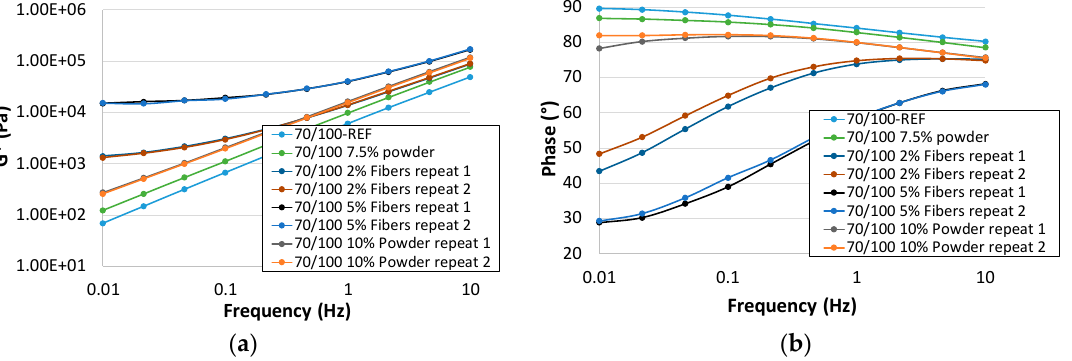
Figure 11. Frequency sweeps at 50 °C, 1% strain: ( a ) complex modulus and ( b ) phase angle.